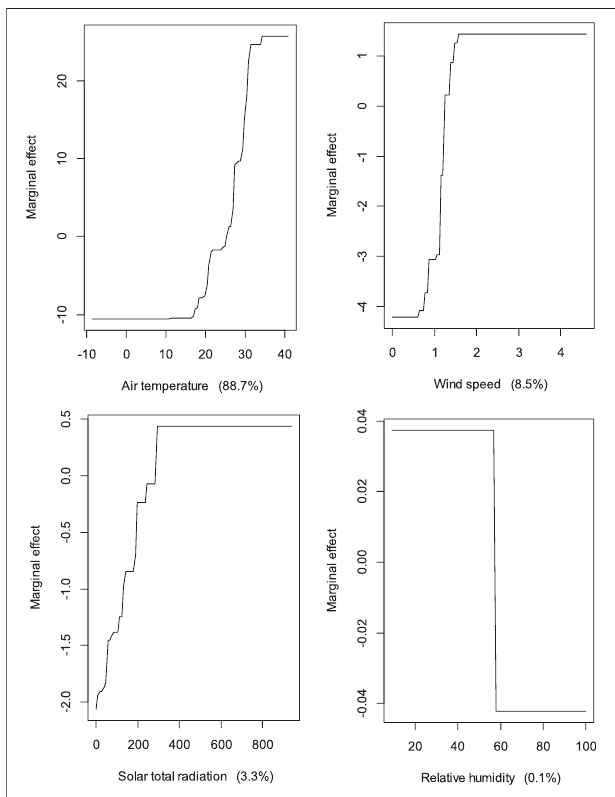
FIGURE 5 | Marginal effects of the four factors on the O 3